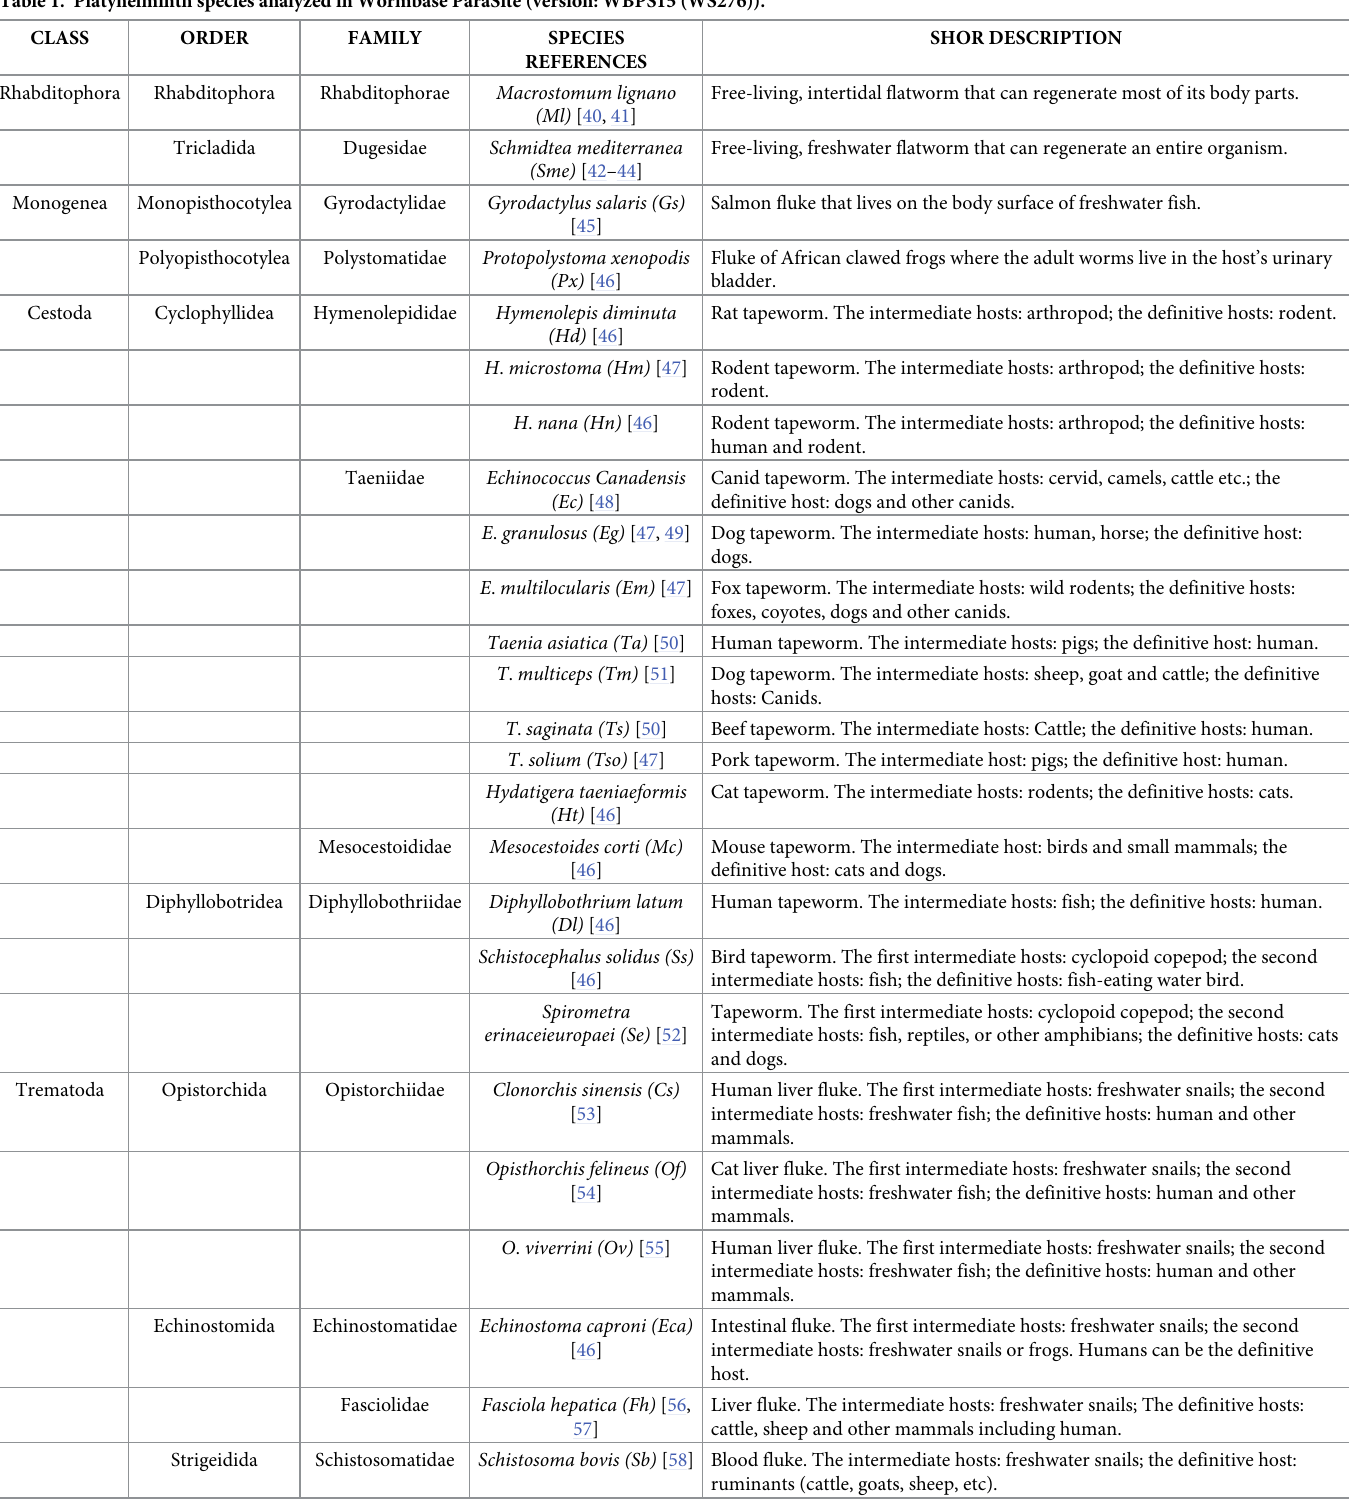
Table 1. Platyhelminth species analyzed in Wormbase ParaSite (version: WBPS15